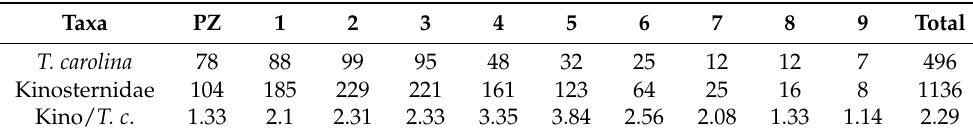
Table 7. T. carolina and Kinosternidae counts by